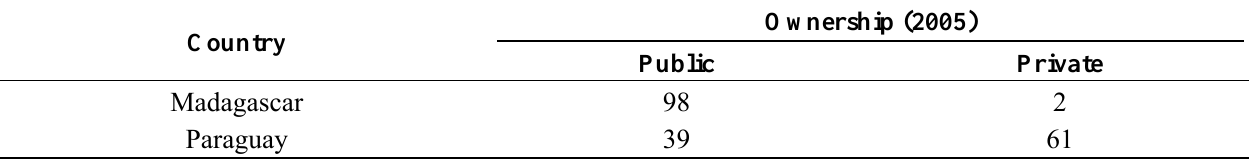
Table 2. Forest ownership in Madagascar and